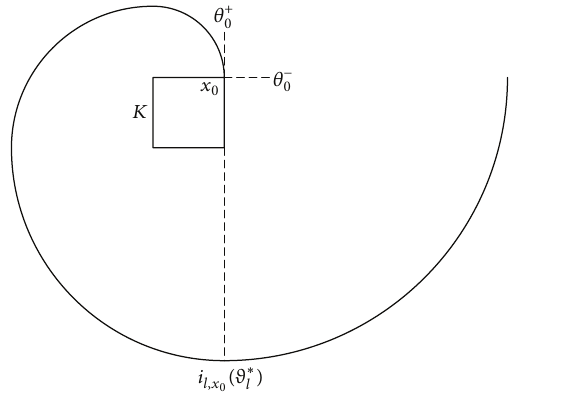
Figure 1: Left involute of a square.